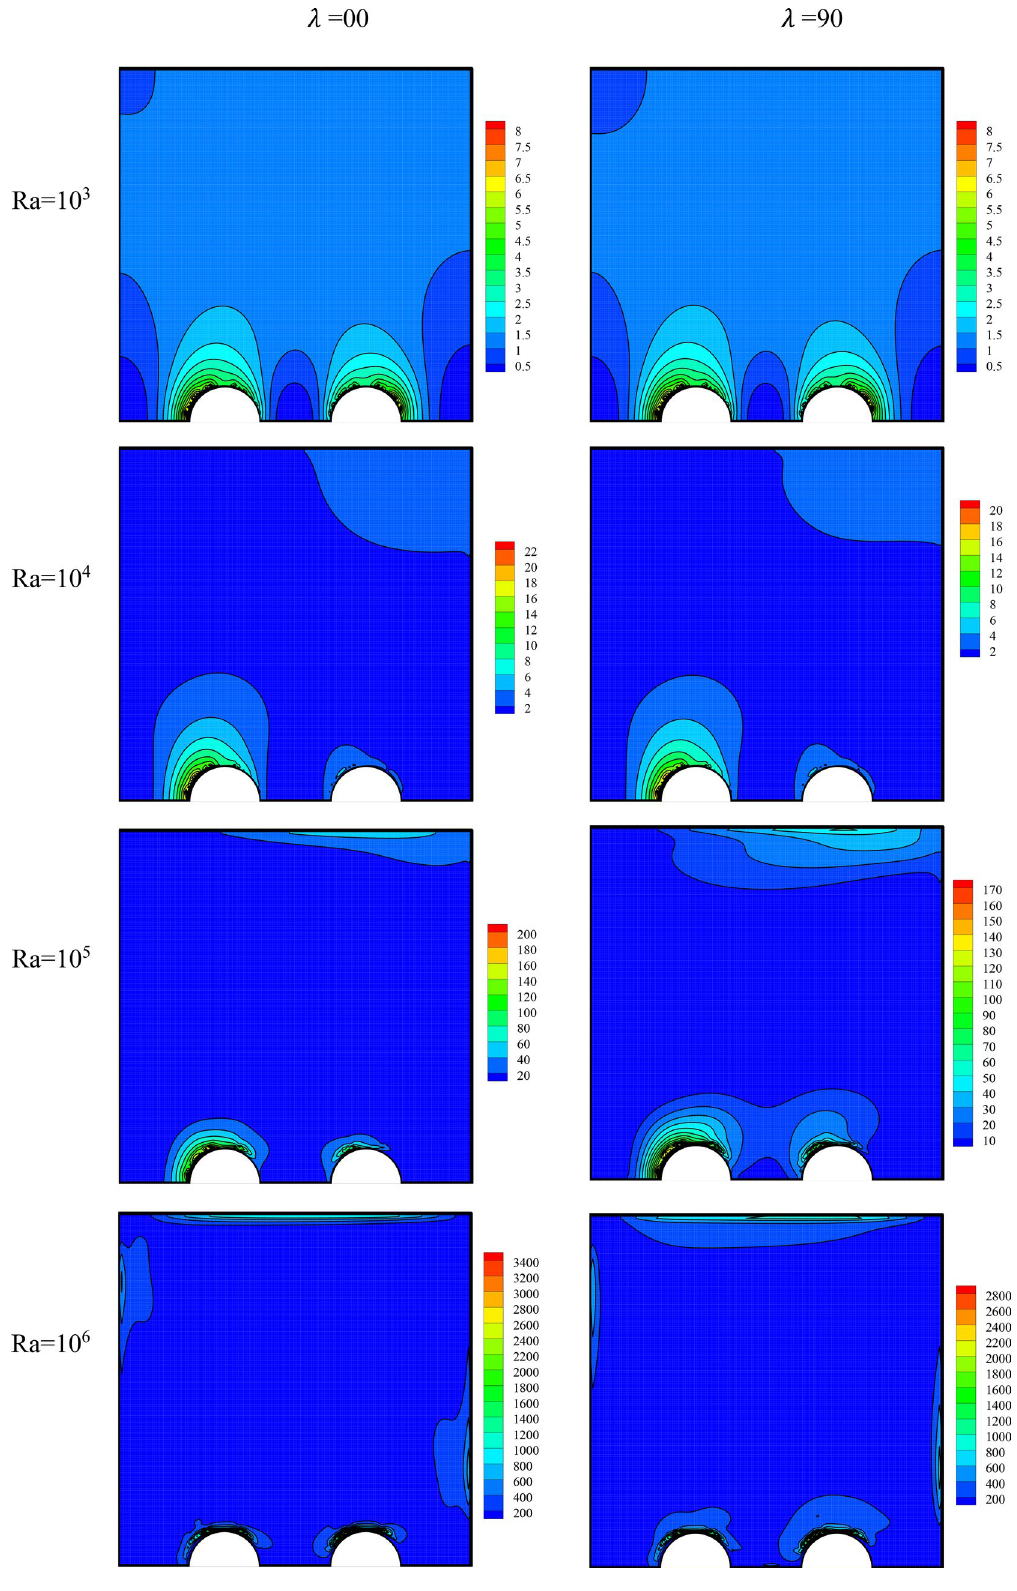
Figure 10. The entropy generation field for varying values of Ra and MF angle at φ = 0.3, γ = 45°, Ha = 20, Rad =